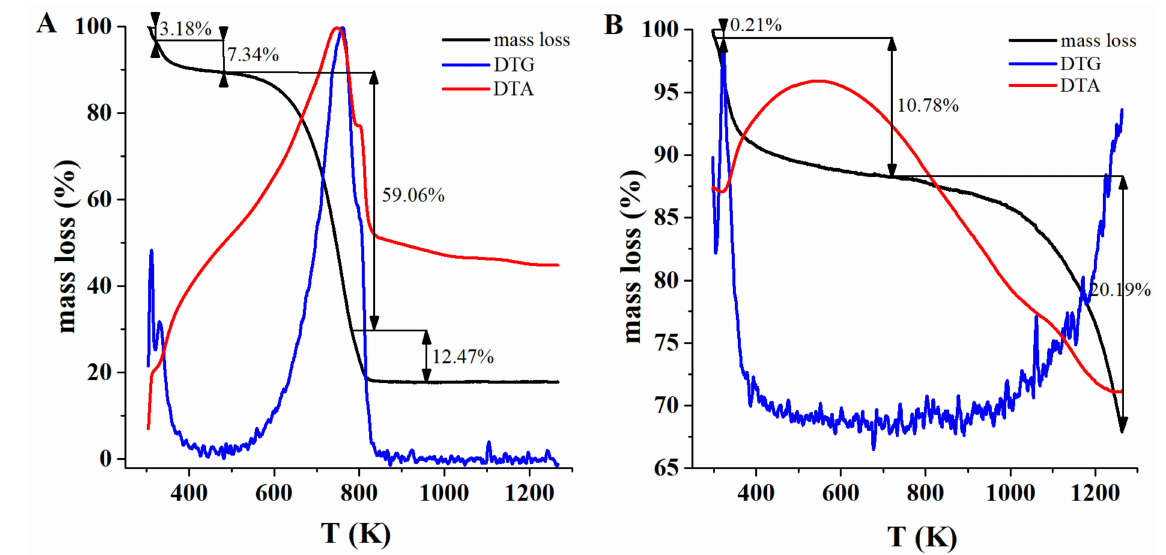
Figure 6. Thermogravimetric analysis: ( A ) air atmosphere; ( B ) nitrogen atmosphere.